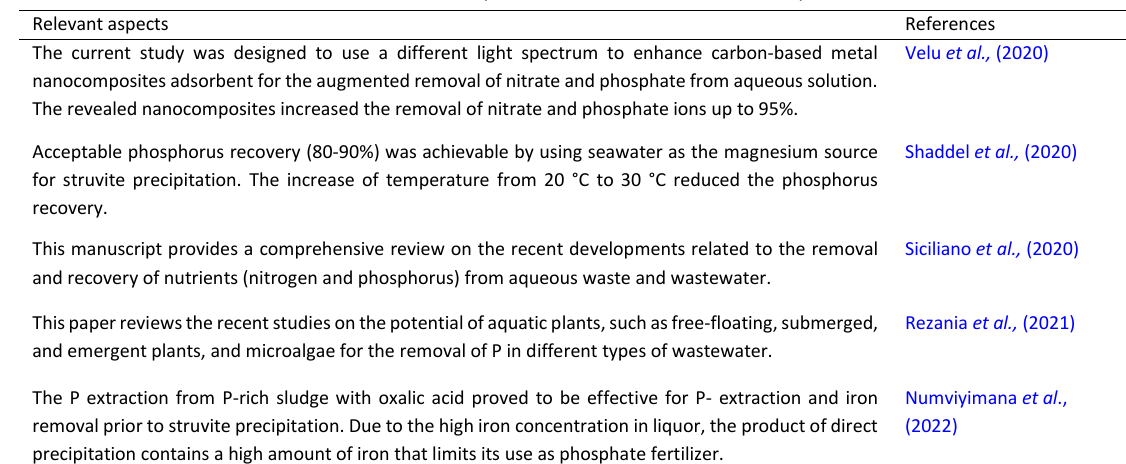
Table 1: Summary of the recent studies about P-recovery